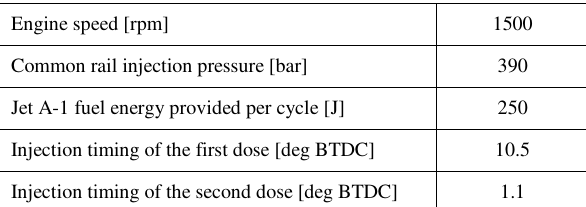
Table 5. Engine adjustment parameters for dual fueling with Jet A-1 and propane for PCCI mode Engine speed [rpm] 1500 Common rail injection pressure [bar] 390